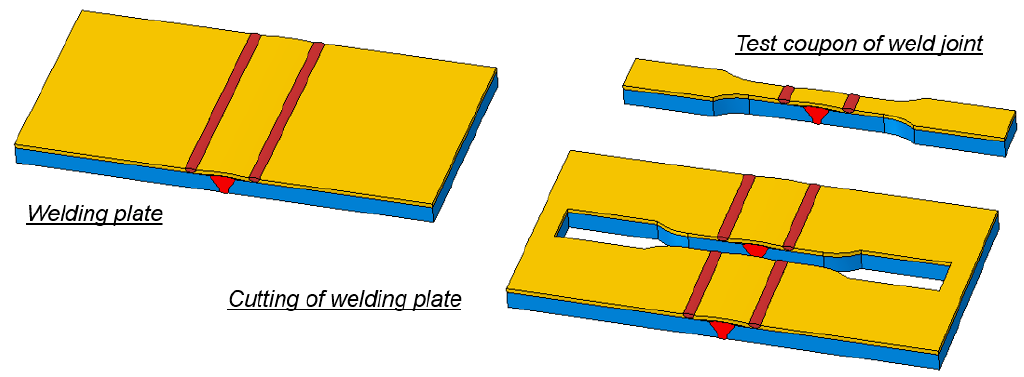
Figure 5. Manufacture of test coupons from TC bimetallic steel welding plates.